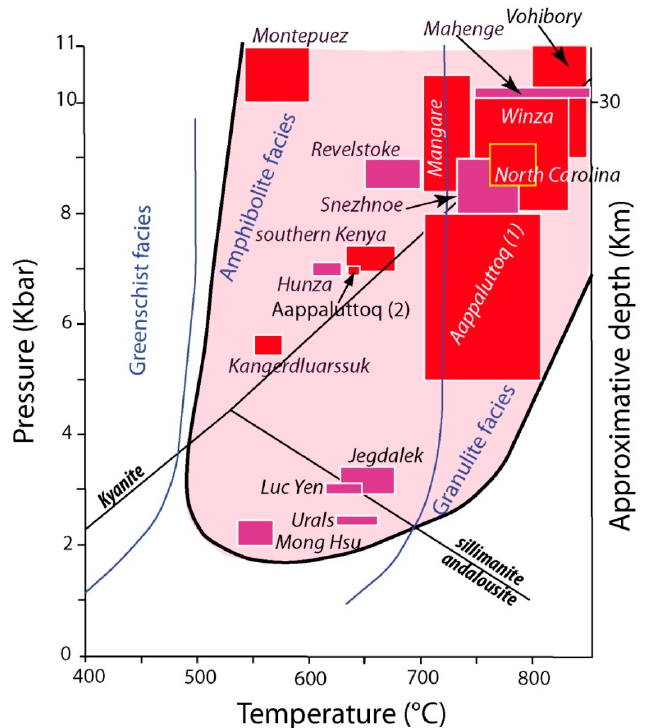
Figure 21. Pressure–temperature (P–T) formation conditions of metamorphic gem ruby (modified from [40,110]). The P–T fields of: (1) the marble type deposits from Mong Hsu [60], Urals [111], Luc Yen and Jegdalek [65], Hunza [112], Revelstoke [113], Mahenge [114], and Snezhnoe [115] are represented by violet rectangles and (2) the M-UMR deposits, metamorphic sensu stricto or associated with metasomatic metamorphism are represented by red rectangles: Greenland-Kangerdluarssuk [116], Aappaluttoq 1 [34] and 2 [83]; Southern Kenya [117,118]; Montepuez [96]; Mangare [119]; Winza [120]; North Carolina [121]; and Vohibory [122]. The P–T fields of ruby and pink corundum in clinopyroxenites and metagabbro xenoliths associated with alkali basalts are not shown. The schematic fields of Greenschist, Amphibolite, and Granulite facies are reported.